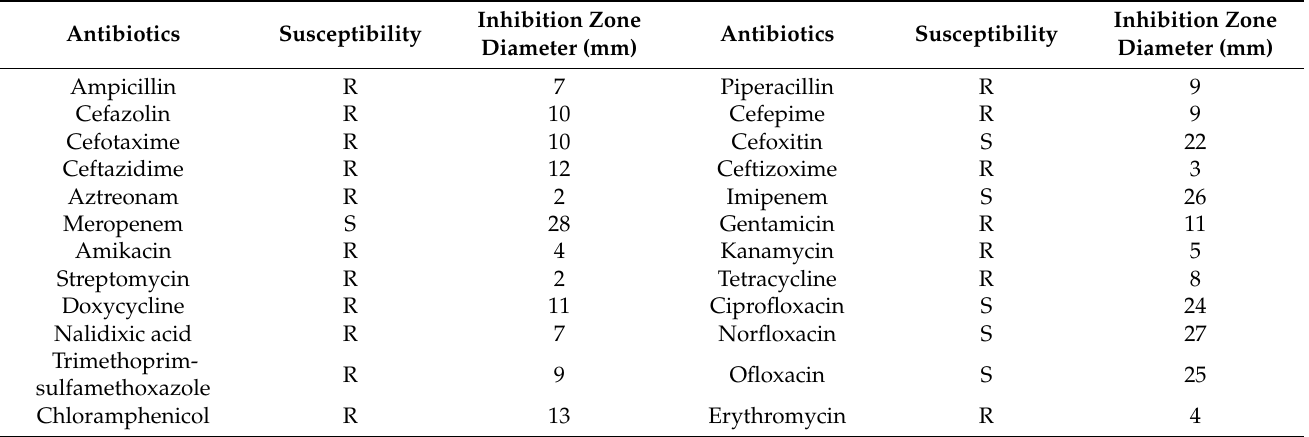
Table 1. Antibiotic susceptibility test performed on C. balustinum WLT by disk diffusion method (R: resistant, S: susceptible, I: